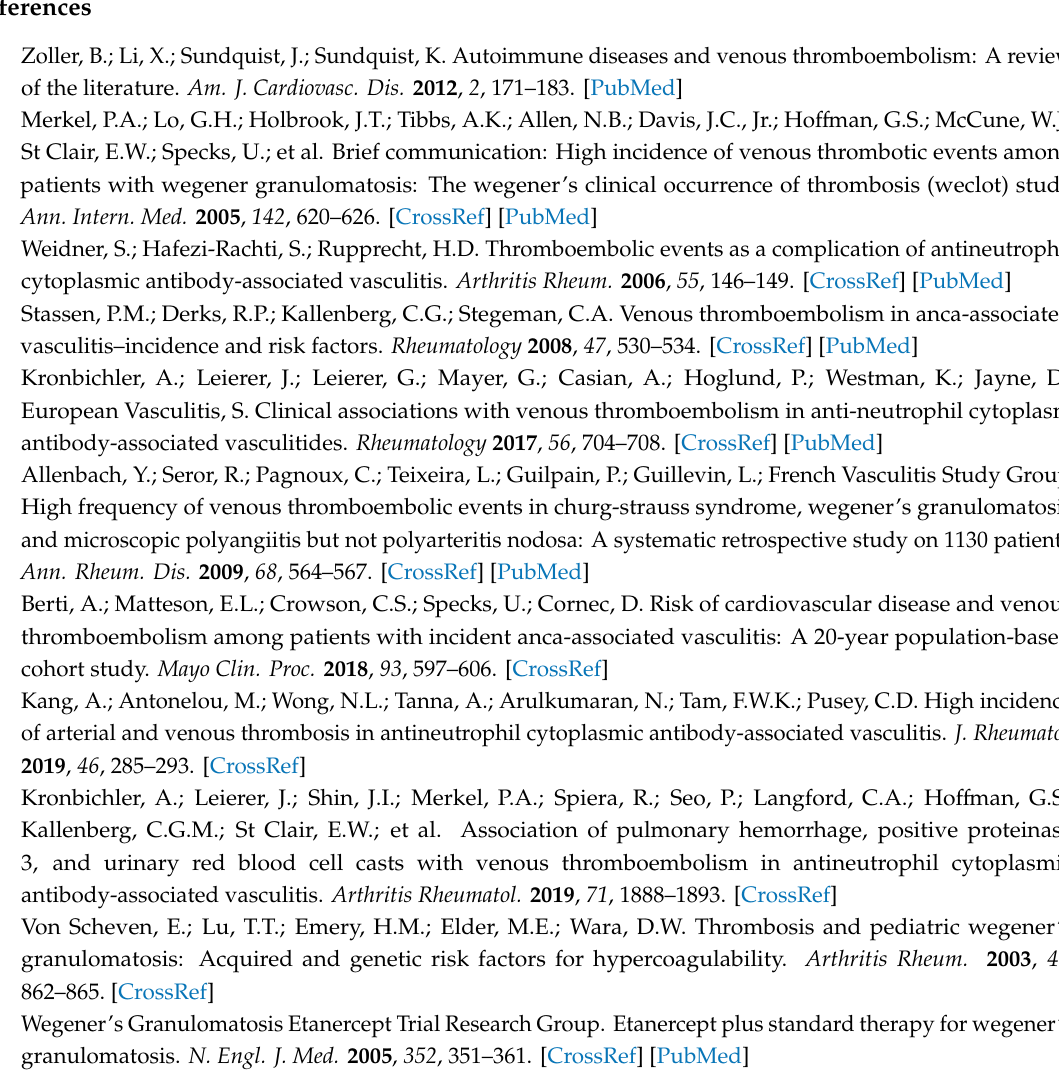
Figure S1: Statin treatment frequency according to center, Table S1: Search for a hypercoagulability state. Results are given as absolute values and percentages, Table S2: Baseline characteristics of patients according to statin treatment at